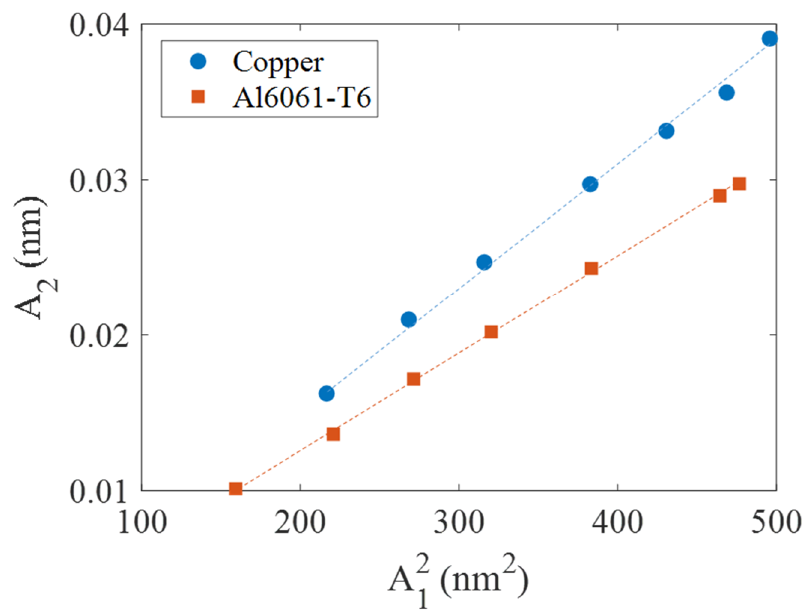
Figure 8. Linear fitting plots of (cid:1827) (cid:2869) (cid:2870) and (cid:1827) (cid:2870) for copper (blue circle) and Al6061-T6 (brown square) specimens. Table 2. Measured absolute parameters ( (cid:2010) (cid:3004)(cid:3048) ) and ( (cid:2010) (cid:3002)(cid:3039) ) .